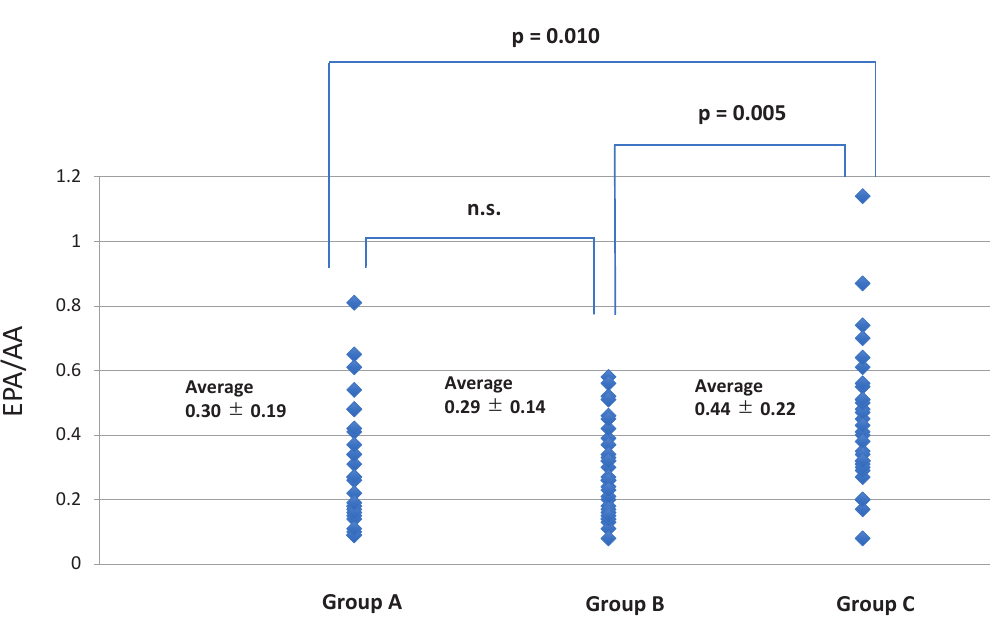
Figure 2. Serum EPA/AA ratios of the three groups.